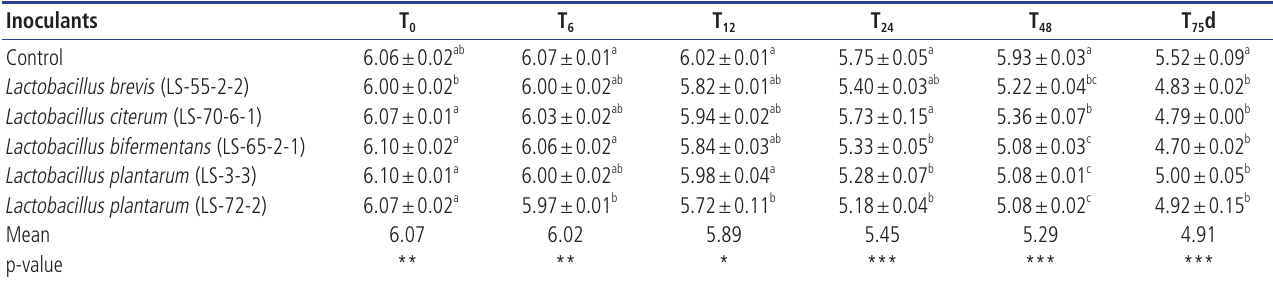
Table 2. Effects of different bacterial inoculants on pH values of ensiled silages at different silage opening times Inoculants